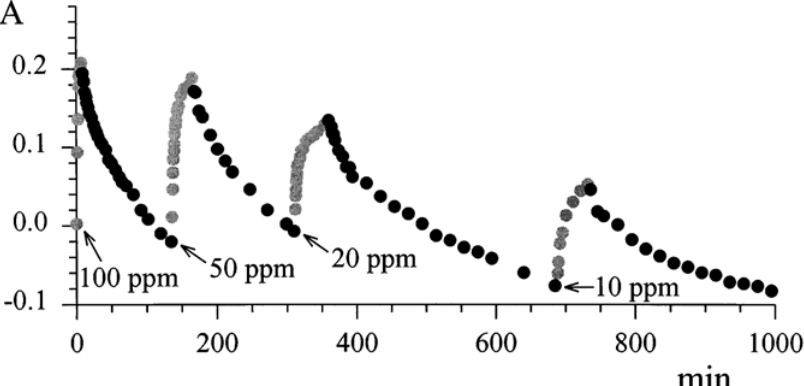
Figure 8. Absorbance versus time for λ 720 nm for different cycles of NO versa of TiPc immobilised on the plastic reflector (the ‘optode’) exposed to different 2, in correspondence with the arrows. Reproduced with the permission concentrations of NO 2 from reference